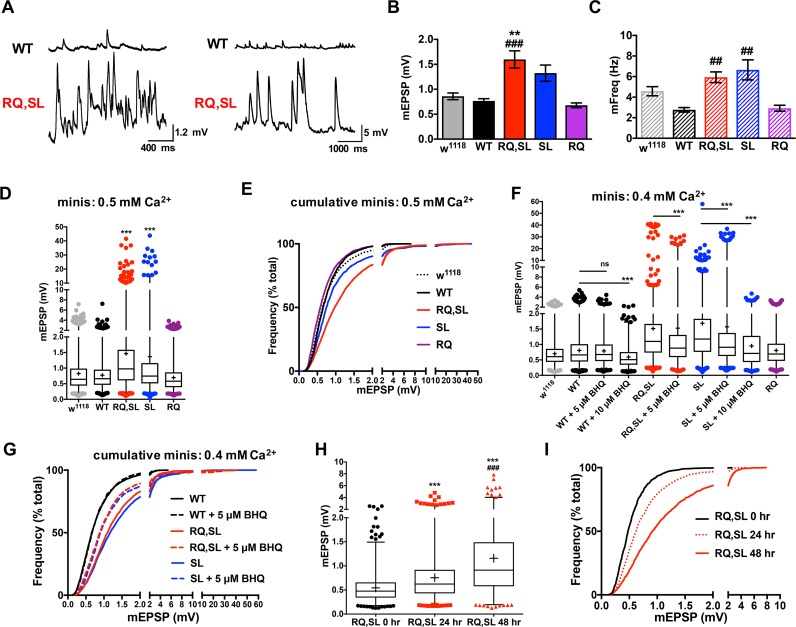
SL- and RQ,SL-expressing NMJs have enhanced mEPSPs.(A) Electrophysiological traces of spontaneous activity at WT- and RQ,SL-expressing NMJs. Example traces with two different scales show variable severity of spontaneous neurotransmission phenotypes, in terms of frequency severity (left) or amplitude severity (right). (B) Effects of genotype on average spontaneous mEPSP amplitude (** p < 0.01 vs. w1118 by one-way ANOVA with Tukey’s post-hoc; ### p < 0.001 vs. WT by one-way ANOVA with Tukey’s post-hoc. (C) Effects of genotype on spontaneous mEPSP frequency. ## p < 0.01 vs. WT by one-way ANOVA with Tukey’s post-hoc; n ≥ 12 NMJs, all genotypes. (D) Box and whisker plots of mEPSP amplitude range at 0.5 mM extracellular [Ca2+]. Box denotes 25th-75th percentile; line denotes median; + sign denotes average; whiskers range from 1st-99th percentile; individual data points outside the 1st and 99th percentiles are plotted; (*** p < 0.001 by Kruskal-Wallis ANOVA with Dunn’s post-hoc vs. either w1118 or WT; n > 1400 mEPSPs for each genotype). (E) Cumulative probability histogram of the data in (D) showing a marked rightward shift in mEPSP amplitudes for SL- and RQ,SL-expressing NMJs. (F) Box and whisker plot (as in (D)) of mEPSP amplitude at 0.4 mM extracellular [Ca2+] with and without the CaV2.1 channel modifier BHQ (*** p < 0.001 by Kruskal-Wallis ANOVA with Dunn’s post-hoc vs. identical genotype +/- BHQ; n > 985 mEPSPs for each genotype). (G) Cumulative probability histogram of a subset of data in (F). 5 μM BHQ causes a partial leftward shift in the distribution of events for SL- and RQ,SL-expressing NMJs while not affecting WT-expressing NMJs. (H) Box and whisker plot (as in (D)) of mEPSP amplitude range when expressing the RQ,SL transgene for acute periods of developmental time (*** p < 0.001 by Kruskal-Wallis ANOVA with Dunn’s post-hoc vs. RQ,SL 0 hr., ### p < 0.001 by vs. RQ,SL 24 hr.; n > 1095 mEPSPs for each genotype). (I) Cumulative probability histogram of the data in (H) showing a rightward shift in mEPSP amplitudes for longer periods of RQ,SL expression.